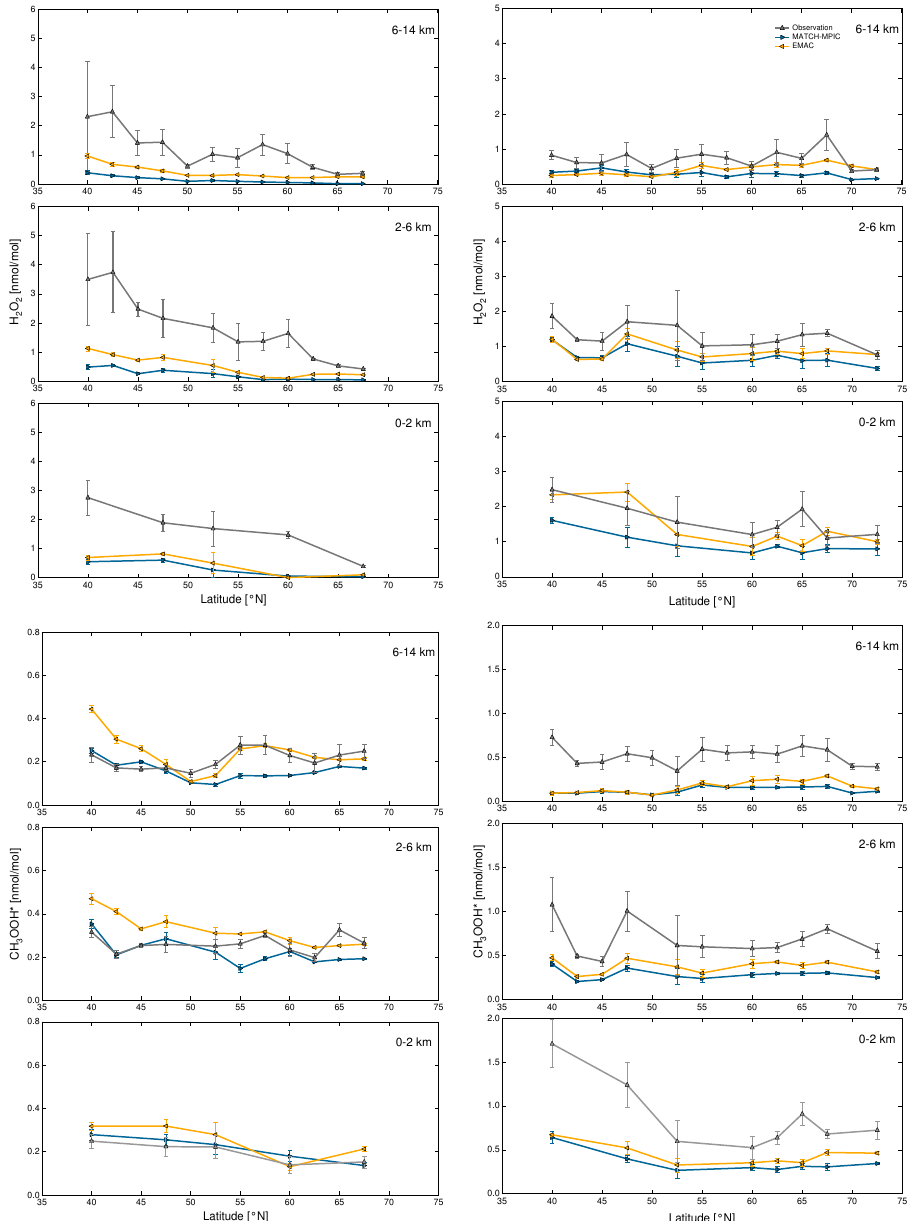
Fig. 7. Latitude gradients of H 2 O 2 (upper panels) and CH 3 OOH ∗ (lower panels) for HOOVER 1 in October 2006 (left panels) and HOOVER 2 in July 2007 (right panels). Data is subdivided into 3 altitude intervals representing the BL, the MT and the UT. The median values of in-situ measurements (grey), EMAC simulations (orange) and MATCH-MPIC simulations (blue) are shown together with 2 sigma as error bars.